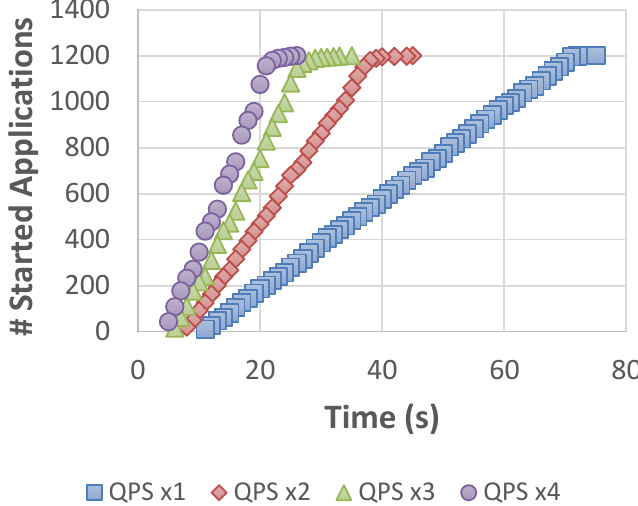
Fig. 2 . Number of started pause containers as a function of time for a cluster of 240 hosts and five replicas per host. Time is counted from the moment the command to deploy the containers is sent to Kubernetes. Measured times are reported for four different values of the QPS parameter Fig. 1. Time to scale the pause container up to five replicas per node as a function of the cluster size. The plot reports the measured times for four different values of the QPS parameter set. † Performance of a big cluster is sensitive to the size of the Kubernetes “master” node (i.e., the cluster control plane). The Kubernetes documentation indicates that the reported performance figures were achieved running tests on the Google Compute Engine using a n1-standard-32 [14] virtual machine for the master node.